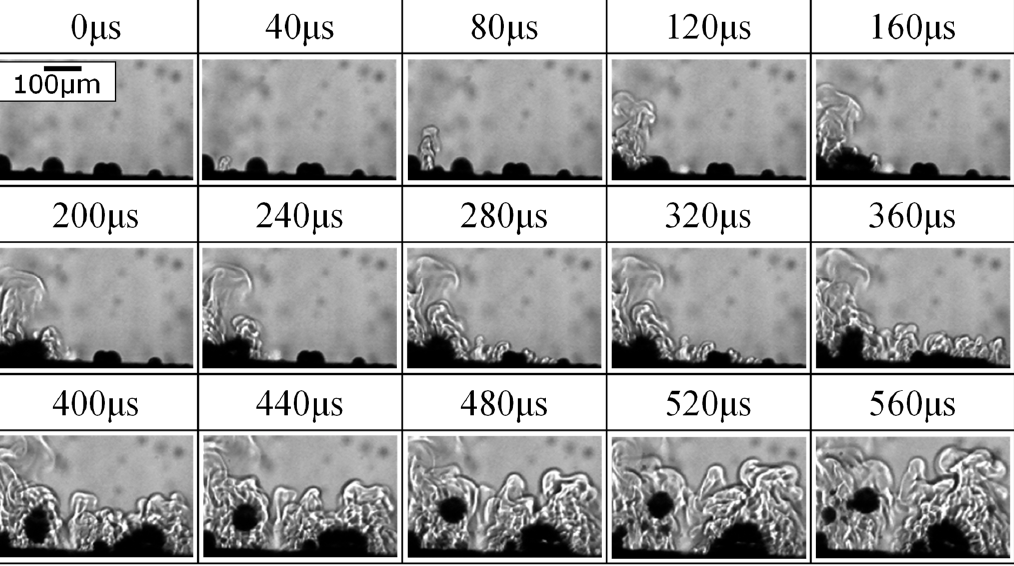
Figure 11. Behavior of micro-arcs, ejected materials, and bubbles in the side view during the PEO process by ST operation. process by ST